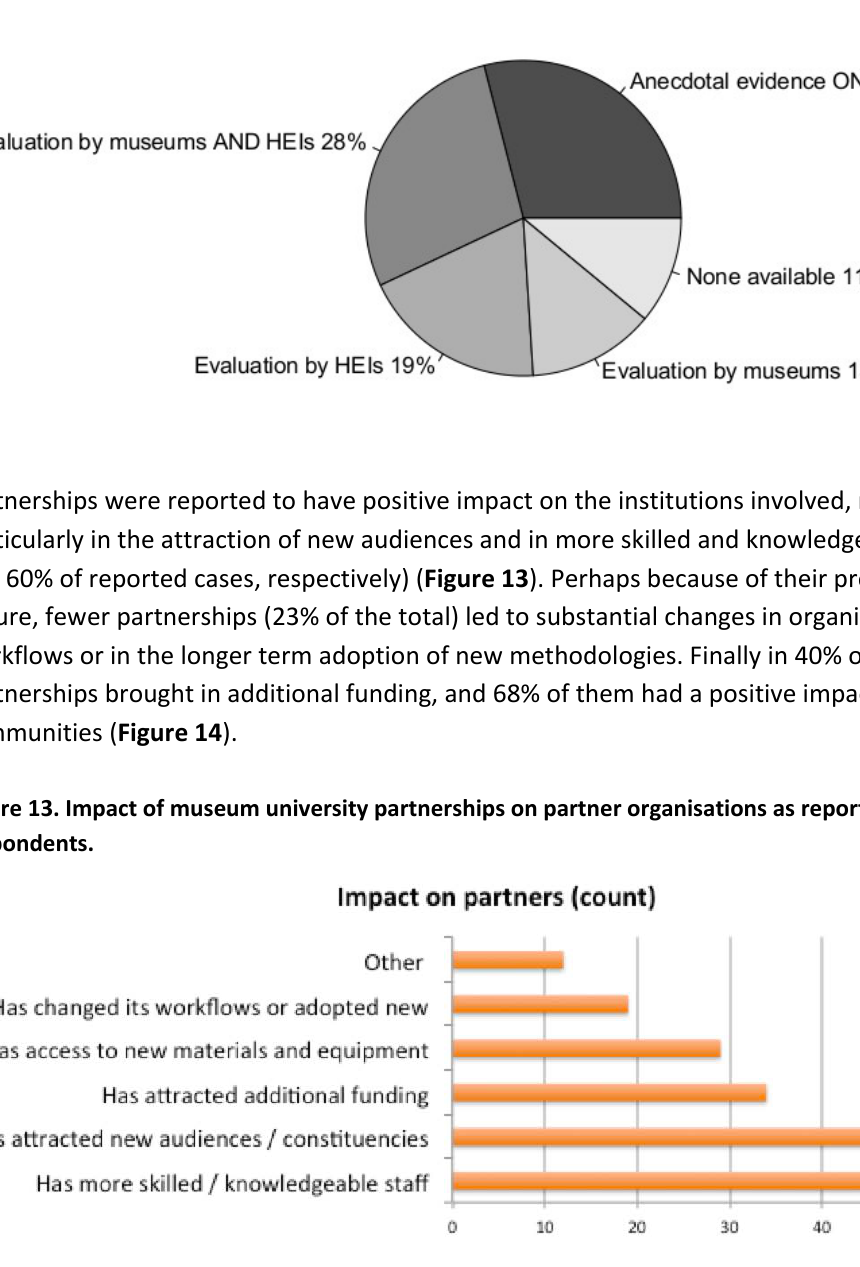
Figure 12. Evidence that museum university partnerships have/have not delivered against its aims, as shown by survey data.